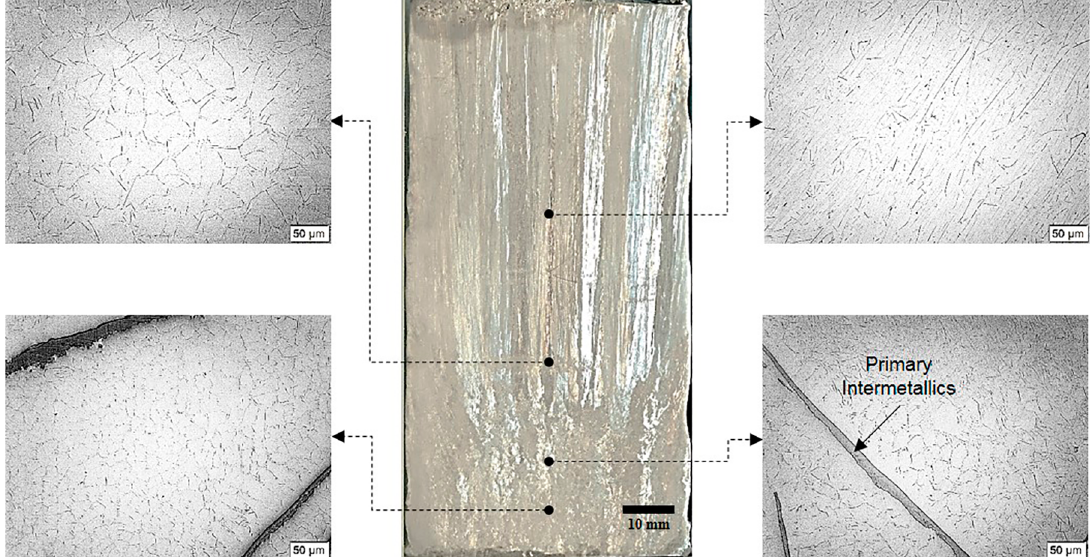
Figure 6. Columnar grains macrostructure and selected transverse microstructures showing the β-Sn morphological evolution from the bottom to top of the Sn-0.5wt.%Ni alloy casting